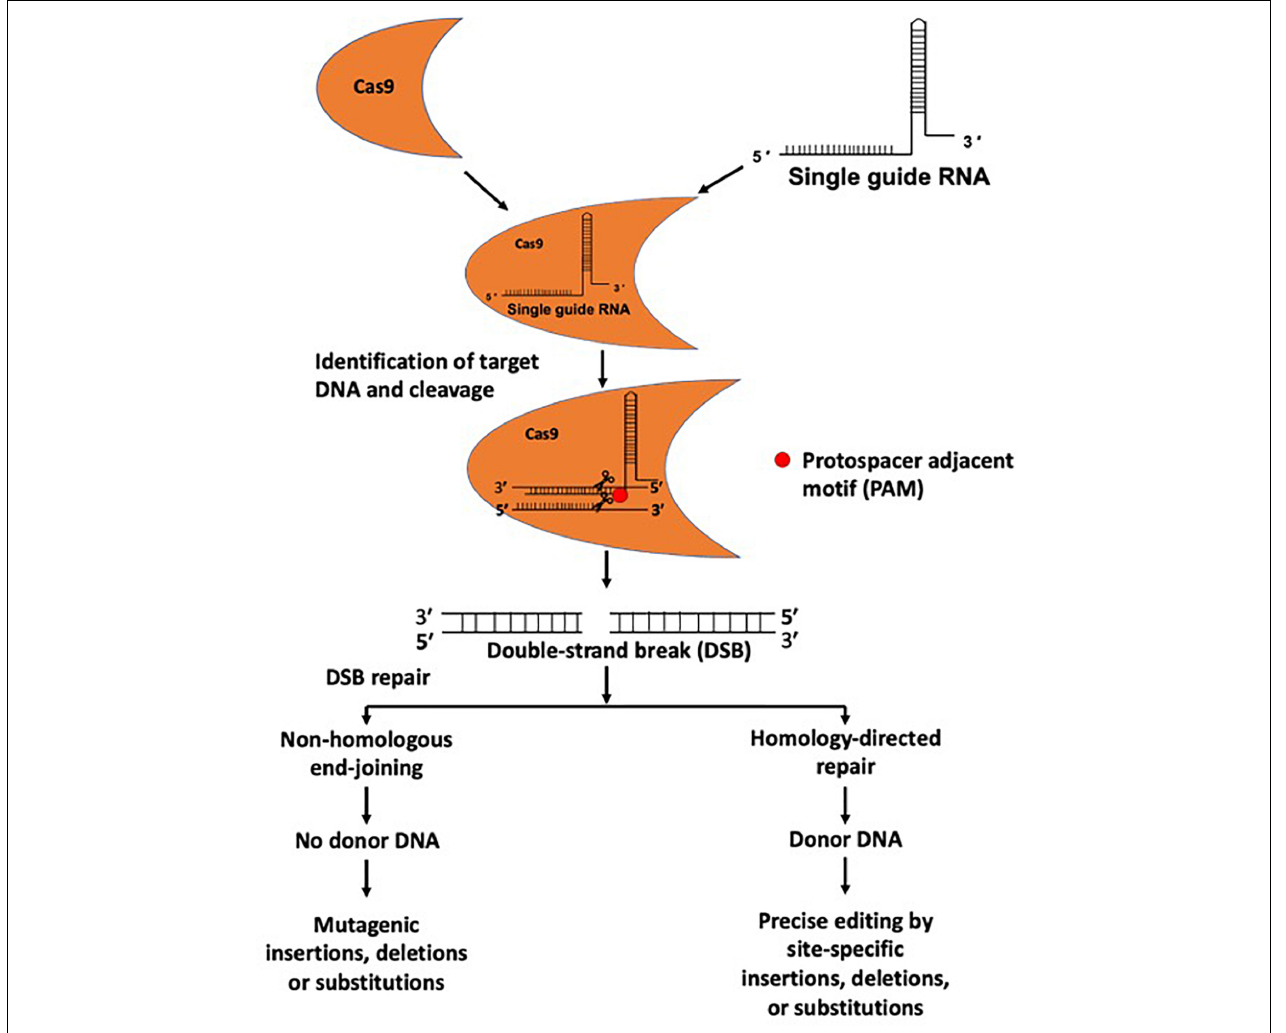
FIGURE 1 | Genome editing using CRISPR/Cas9 system. The CRISPR/Cas9 system is composed of a gRNA and Cas9 protein. gRNAs provide target specificity by sequence complementarity. gRNA and Cas9 proteins form a complex and cleave target DNA at a specific site and produce a double-strand DNA break (DSB). DSBs are repaired through non-homologous end joining (NHEJ) and homology-directed repair (HDR) mechanisms, and during the repair process insertions, deletions, nucleotide substitutions, or gene insertion may